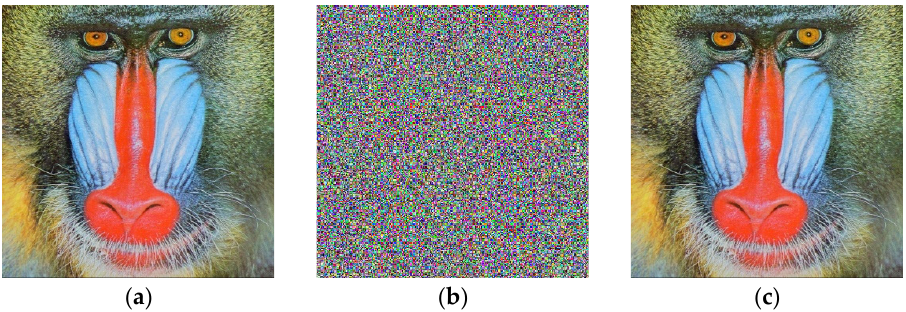
Figure 6. Mandrill encryption process. ( a ) Original image Mandrill; ( b ) encrypted image Mandrill; ( c ) decrypted image Mandrill.